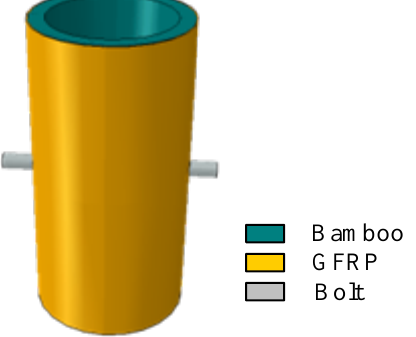
Figure 3. Geometric model of the composite joint.